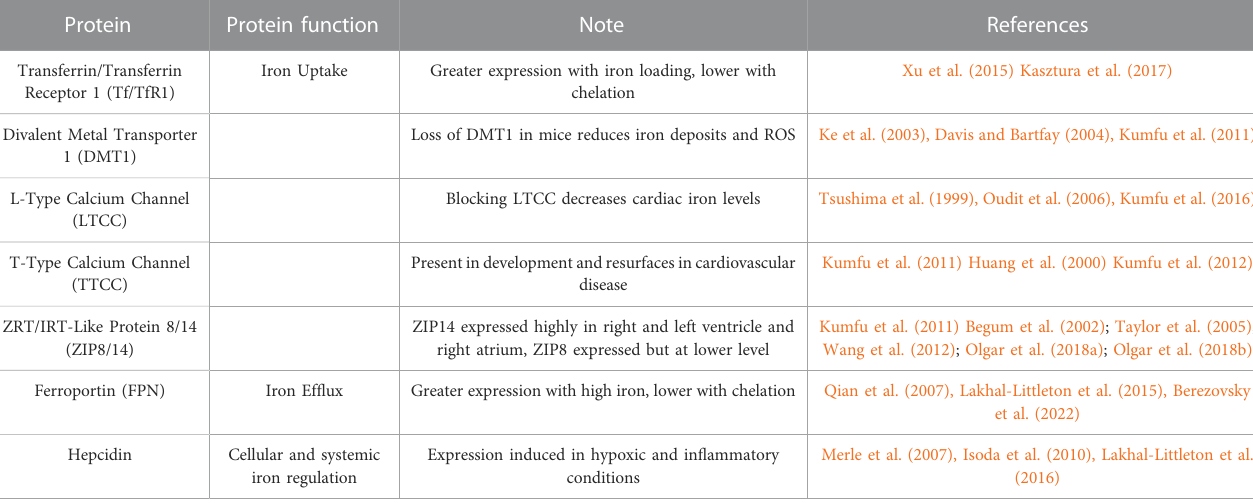
TABLE 1 Iron metabolism proteins expressed in cardiovascular system.